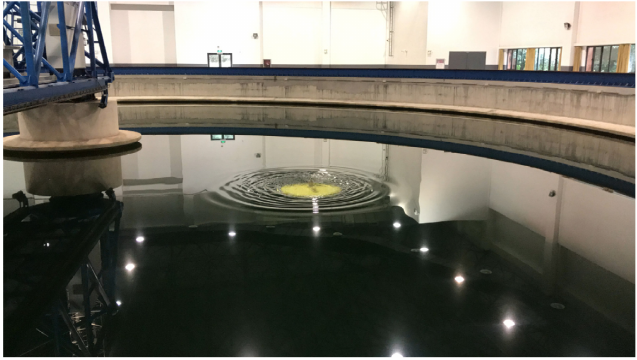
Figure 10. The pool experiment of the AUH.